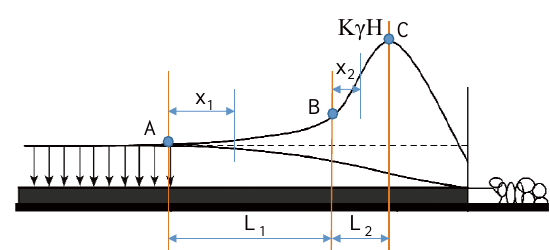
Figure 13. Abutment pressure distribution in front of the working face of the coal seam [36].